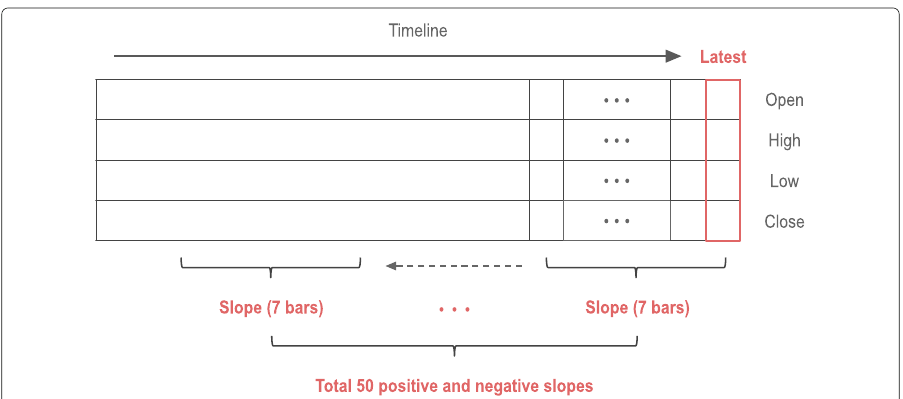
Fig. 8 The flowchart of our slope